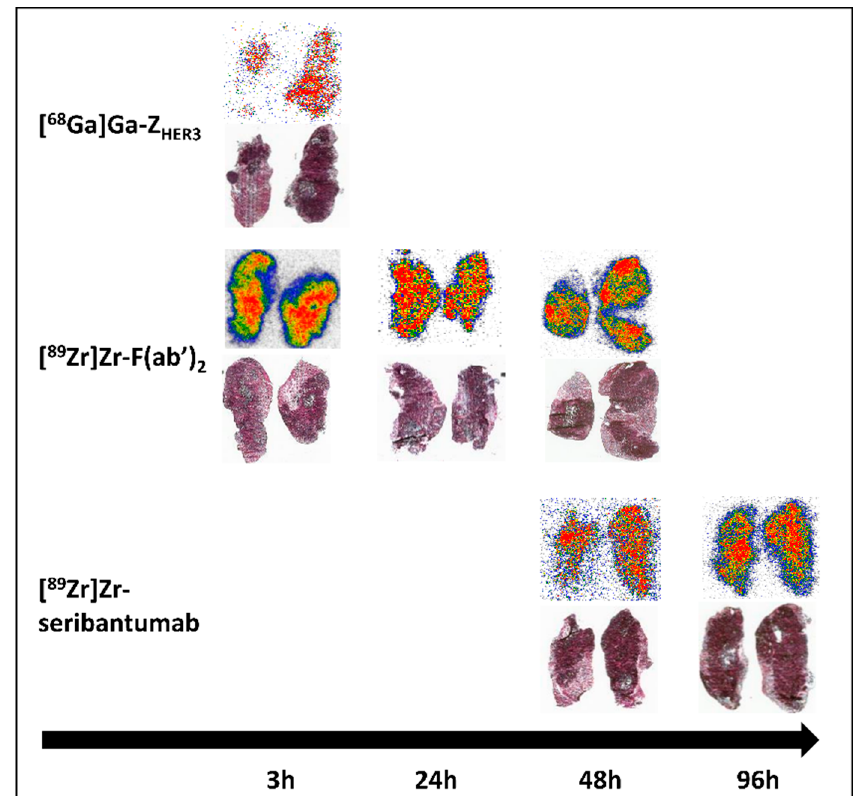
Figure 6. Autoradiography and H&E staining of BxPC-3 xenograft sections. Balb/c nu/nu mice were injected with [ 89 Zr]Zr-DFO-seribantumab-F(ab’) 2 , [ 89 Zr]Zr-DFO-seribantumab, or [ 68 Ga]Ga-Z